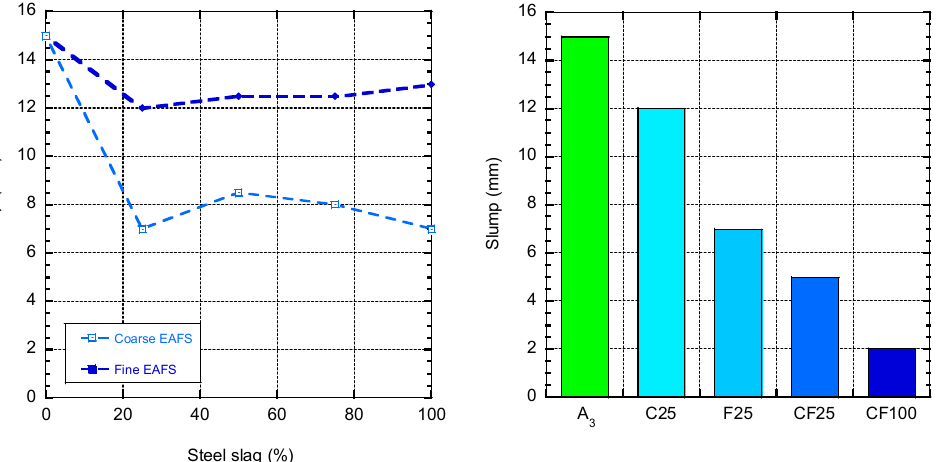
Figure 3. Slump of concrete containing different percentages of EAFS ( left ) and slump of concrete containing 25% of slag ( right ).